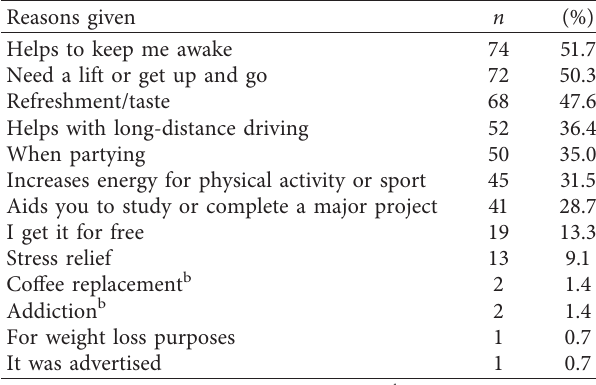
Table 2: Why respondents consume energy drinks ( n � 143) a